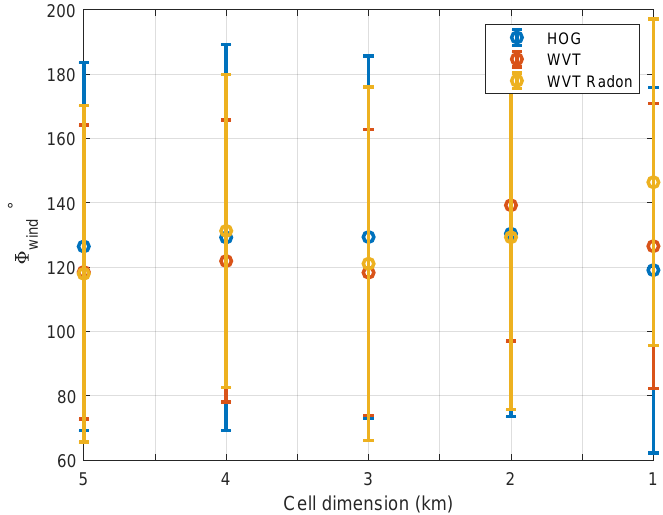
Figure 16. Estimated wave directions in function of cell dimensons for the class C 2